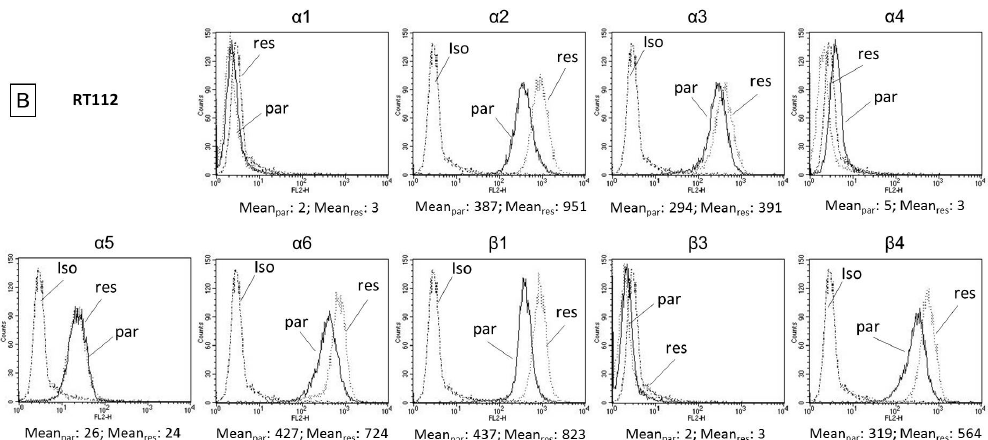
Figure 7. Surface expression of integrin subtypes and isotype control of ( A ) UMUC3par, UMUC3res and ( B ) RT112par, RT112res. Counts indicate MFI (mean fluorescence intensity). One representative of three separate experiments is shown.